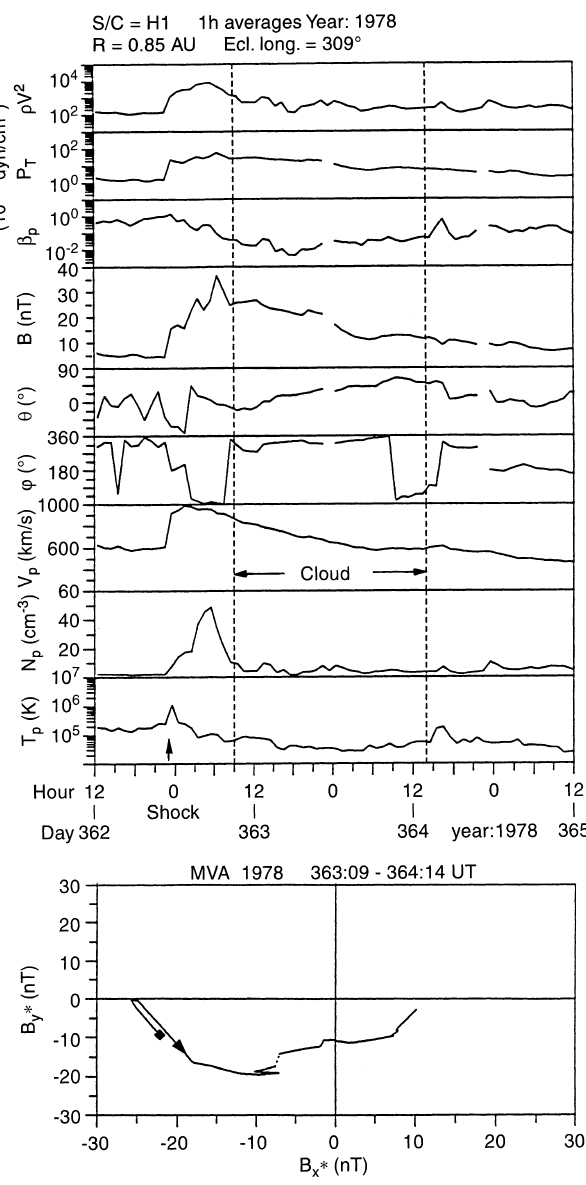
Fig. 5. A MC ( dashed lines ) of type SEN observed with Helios 1 at 0.8 AU on days 240, 14 UT – 241, 10 UT in 1977. The MC was associated with a shock on day 240, 06 UT. D denotes the draping of the IMF in the cloud’s sheath region. The bottom panel shows the clockwise rotation with (cid:135) B y -values in the plane of maximum variance. The calculated axis orientation was (cid:117) (cid:136) 112 (cid:14) , (cid:104) (cid:136) (cid:135) 12 (cid:14) , with a minimum variance direction of (cid:117) (cid:136) 205 (cid:14) , (cid:104) (cid:136) (cid:135) 17 (cid:14) inclined towards the ecliptic (cid:133) (cid:104) (cid:136) (cid:255) 17 (cid:14) (cid:134) . The angles for